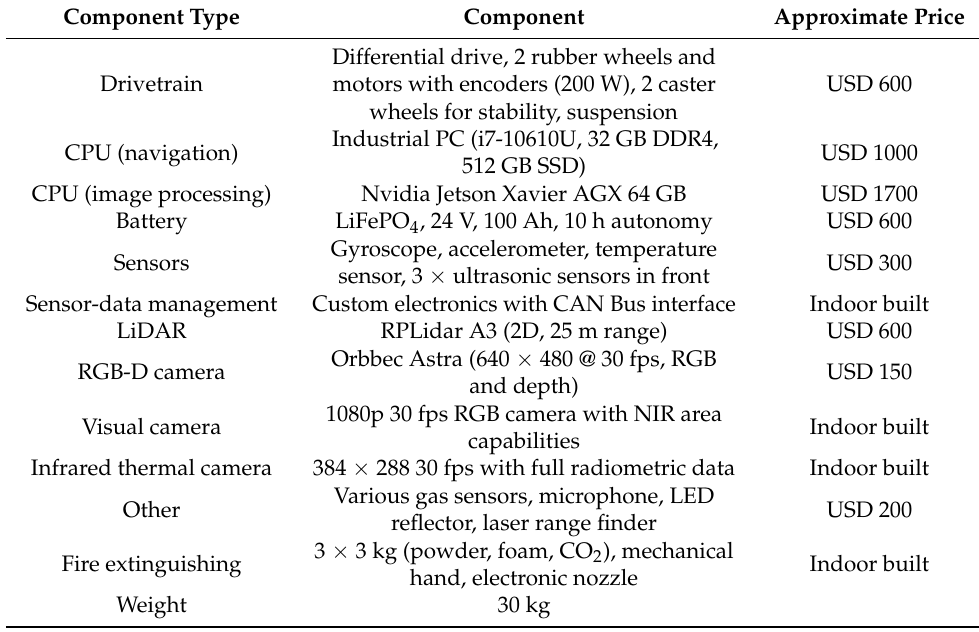
Table 2. Hardware specifications of the final version of